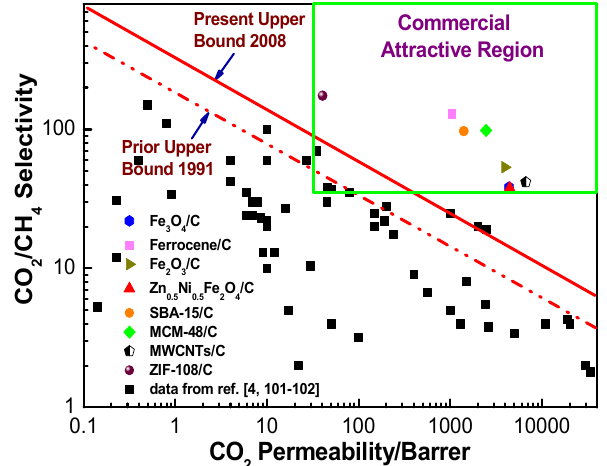
Figure 25. Permeability (CO 2 ) and selectivity (CO 2 /CH 4 ) of hybrid CMS membranes.